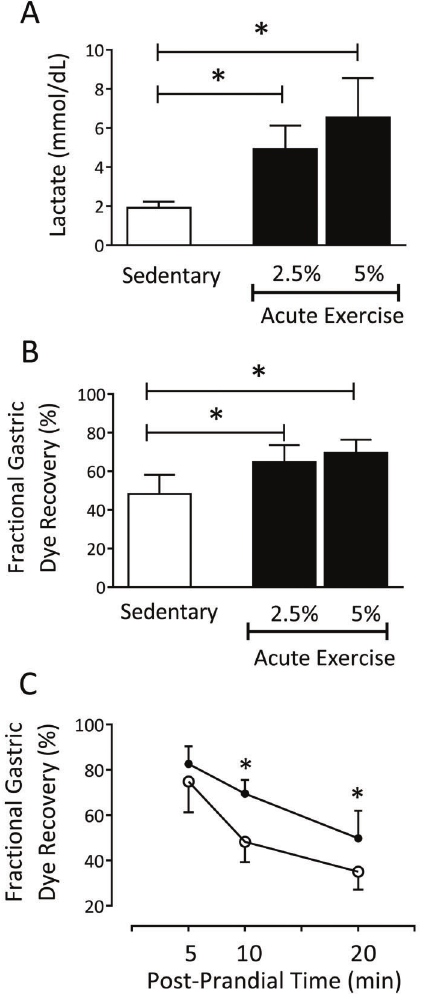
Figure 1. Comparison of blood lactate concentrations ( A ) and fractional gastric dye recovery ( B ) in sedentary and acute exercised (2.5% or 5%) rats at 10 min postprandially. The data are reported as means ± SD. *P o 0.05, sedentary vs acute exercise (2.5% or 5%; ANOVA followed by Tukey ’ s post hoc test). C , gastric retention curve over time in sedentary (clear circles) and acute exercise (5%) rats (black circles) at 5, 10, and 20 min postprandially. The data are reported as means ± SD. *P o 0.05, 5% acute exercise compared to sedentary at 10 and 20 min postprandially (two-way ANOVA followed by the Tukey ’ s post hoc test).